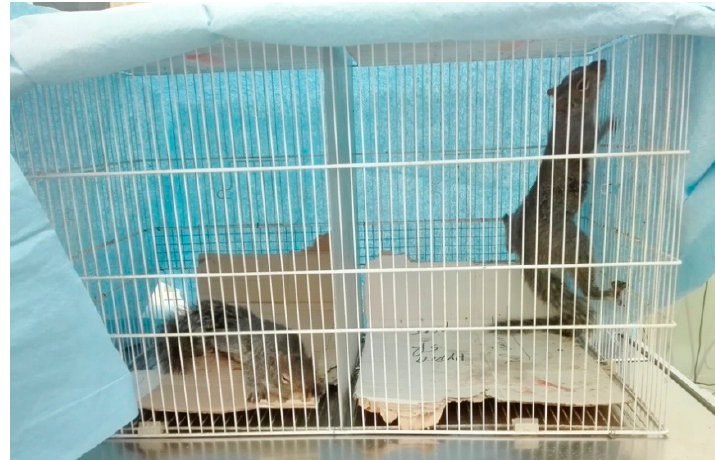
Figure 6. Two gray squirrels placed into a wire-mesh cage with a cardboard padded floor covered